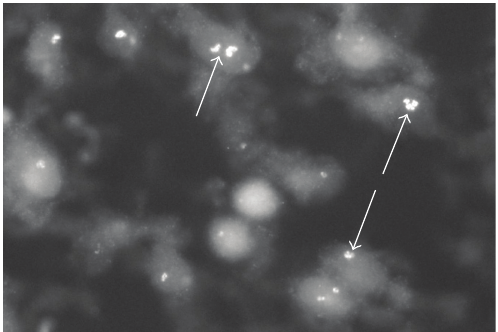
Figure 3: Staining for demonstration of TNF-alpha in a synovial tissue specimen of a rheumatoid arthritis patient. There are specific reactions in inflammatory cells (arrows). The reactions show a granular